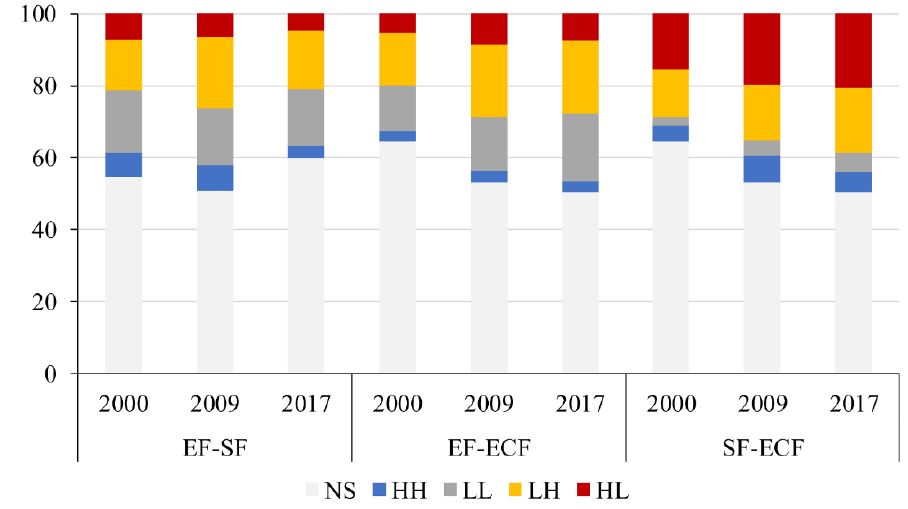
Figure 5. Spatial synergy and trade ‐ off of land use primary functions in Qingpu District during 2000–2017. The results of spatial synergy and trade ‐ off include economic function (EF) and social function (SF) in 2000 ( a1 ), 2009 ( a2 ) and 2017 ( a3 ); economic function (EF) and ecological function (ECF) in 2000 ( b1 ), 2009 ( b2 ) and 2017 ( b3 ); social function (SF) and ecological function (ECF) in 2000 ( c1 ), 2009 ( c2 ) and 2017 ( c3 ).